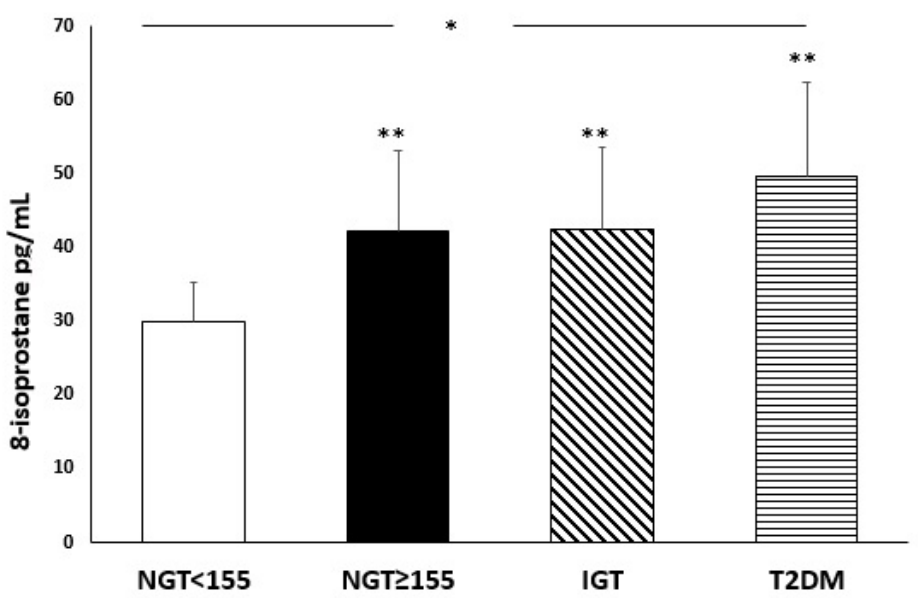
Figure 1. Serum levels of 8-isoprostane (pg/mL) in the four groups according to glucose tolerance status. * p < 0.0001 (ANOVA test); ** p < 0.0001 vs. NGT < 155 (Bonferroni post hoc test).